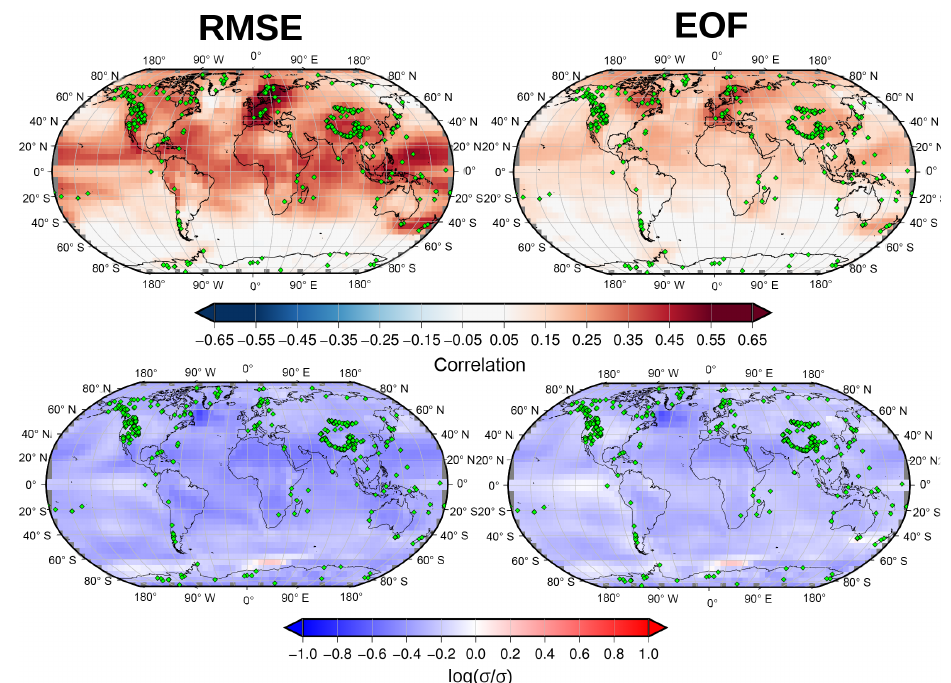
Figure 6. As in Fig. 5 but for the hyperrealistic PPE in which the correlations equal the values obtained during the proxy calibration, i.e. Fig.